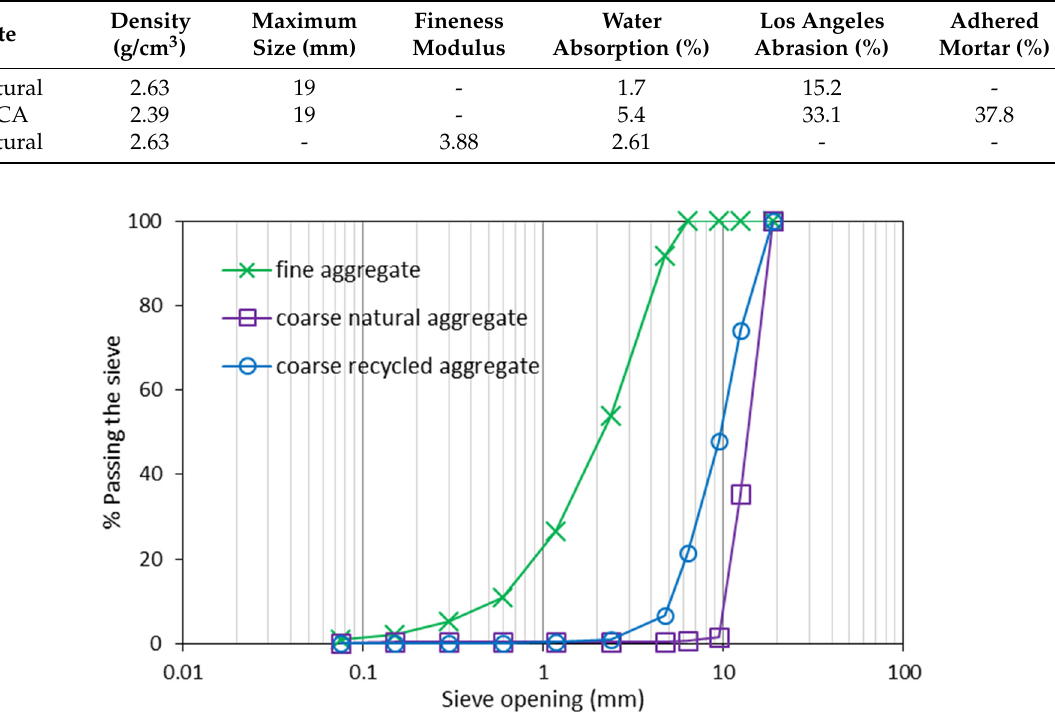
Figure 1. Gradation of the fine and coarse aggregates.